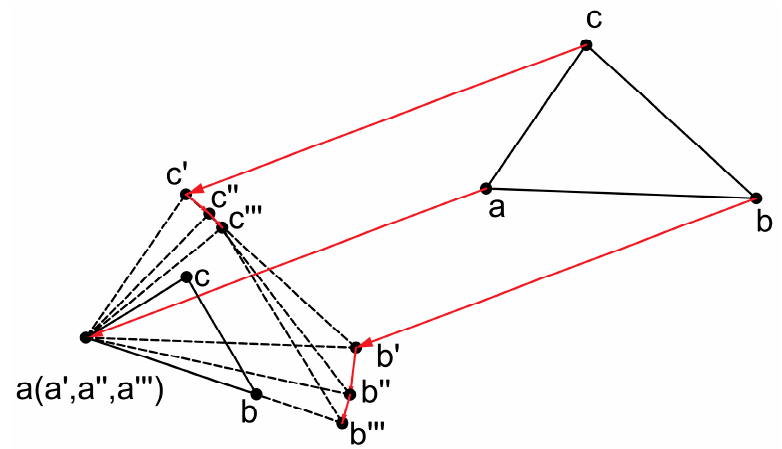
Figure 2. Inverse motion of a shell element.